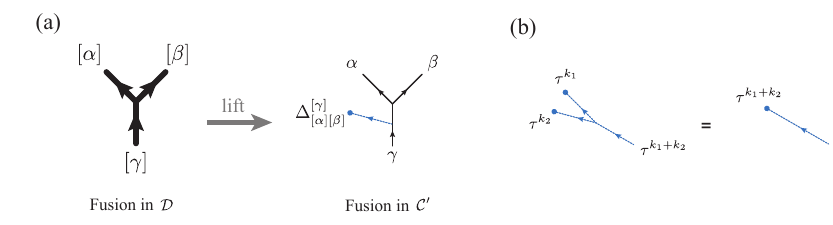
Figure 1: (a) The fusion vertex of the category ˜ D can be lifted into the parent theory ∈ (cid:90) , a single line of condensed C (cid:48) as a fusion diagram shown here. (b) For any k 1,2 transparent anyon τ k 1 + k 2 can be split without extra phase given the proper gauge choice of the F - and R -symbols in C (cid:48) as explained in the main